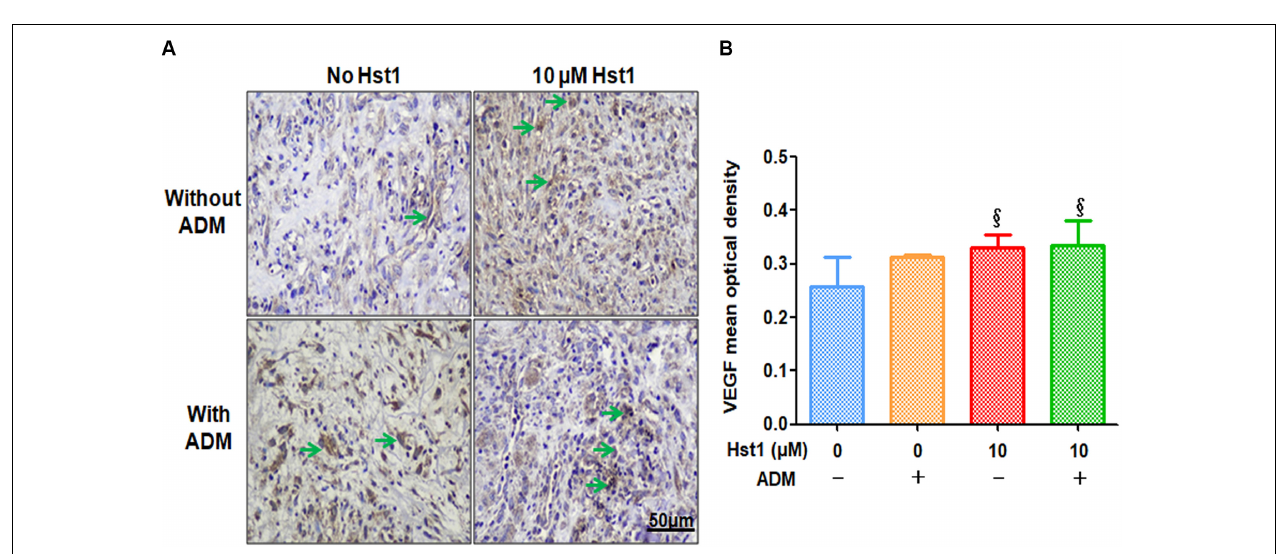
FIGURE 4 | Immunohistochemical evaluation of CD31-positive blood vessels at wound sites. (A) 14 days post-surgery, in the CD31-positive blood vessels (in green arrows) per microscopic field (7.4 ± 0.9) in the 10 µ M Hst1 group was significantly higher than the control group (3.2 ± 1.1). The scale bar = 50 µ m; (B) Quantitative analysis of the number of CD31-positive blood vessels. The 10 µ M Hst1 group presented a higher number of new blood vessels compared with the other groups. §: The 10 µ M Hst1 group vs the control group ( P < 0.05).